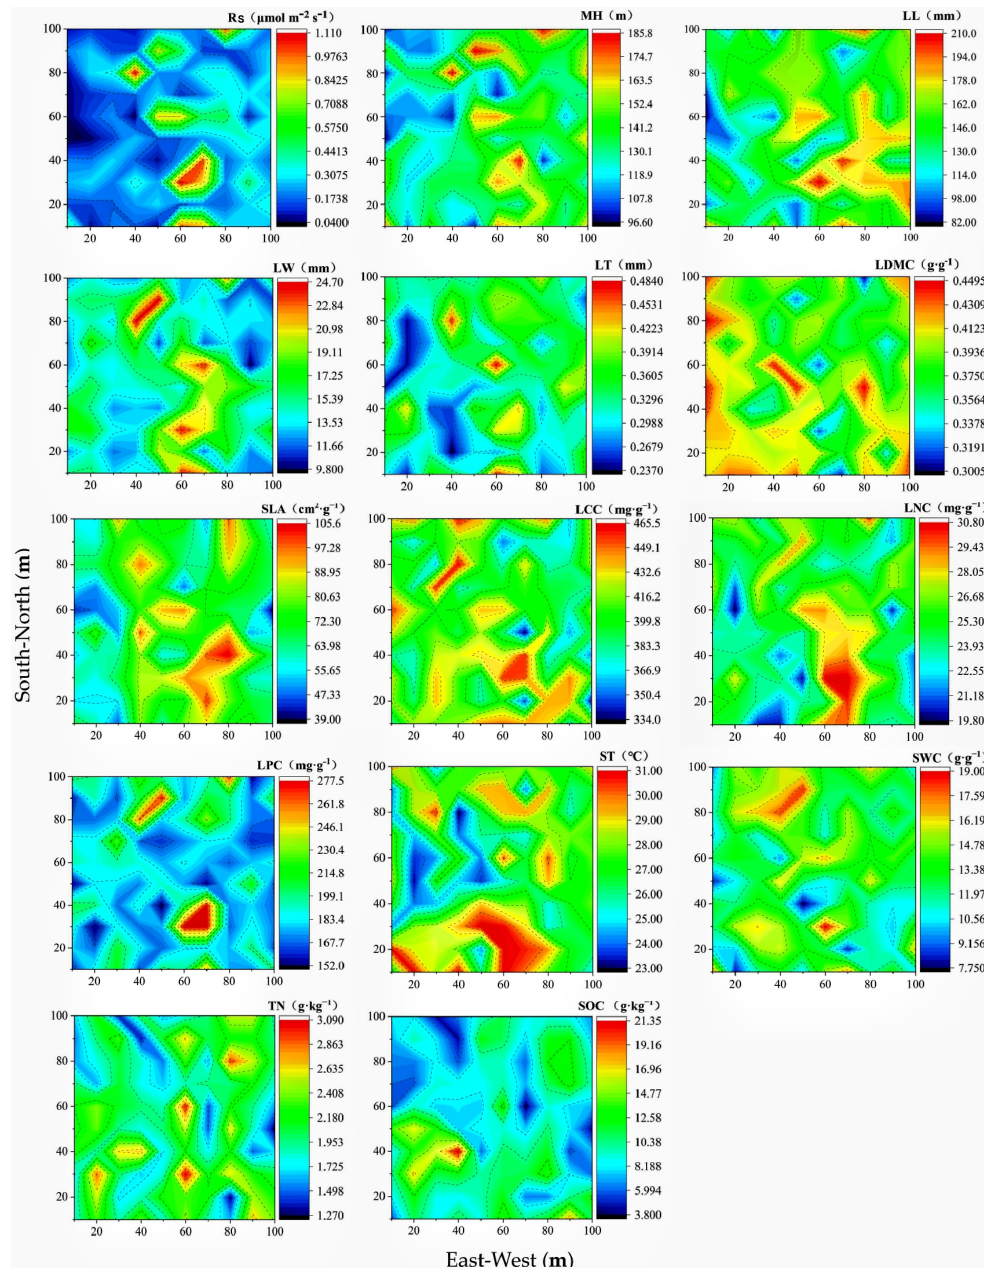
Figure 2. Spatial distribution of soil respiration (Rs), community functional traits, and environmental factors (Legend: MH—Maximum height, LL—Leaf length, LW—Leaf width, LT—Leaf thickness, LDMC—Leaf dry matter content, SLA—Specific leaf area, LCC—Leaf carbon content, LNC—Leaf nitrogen content, LPC—Leaf phosphorus content, ST—Soil temperature, SWC—Soil water content, TN—Total nitrogen, and SOC—Soil organic